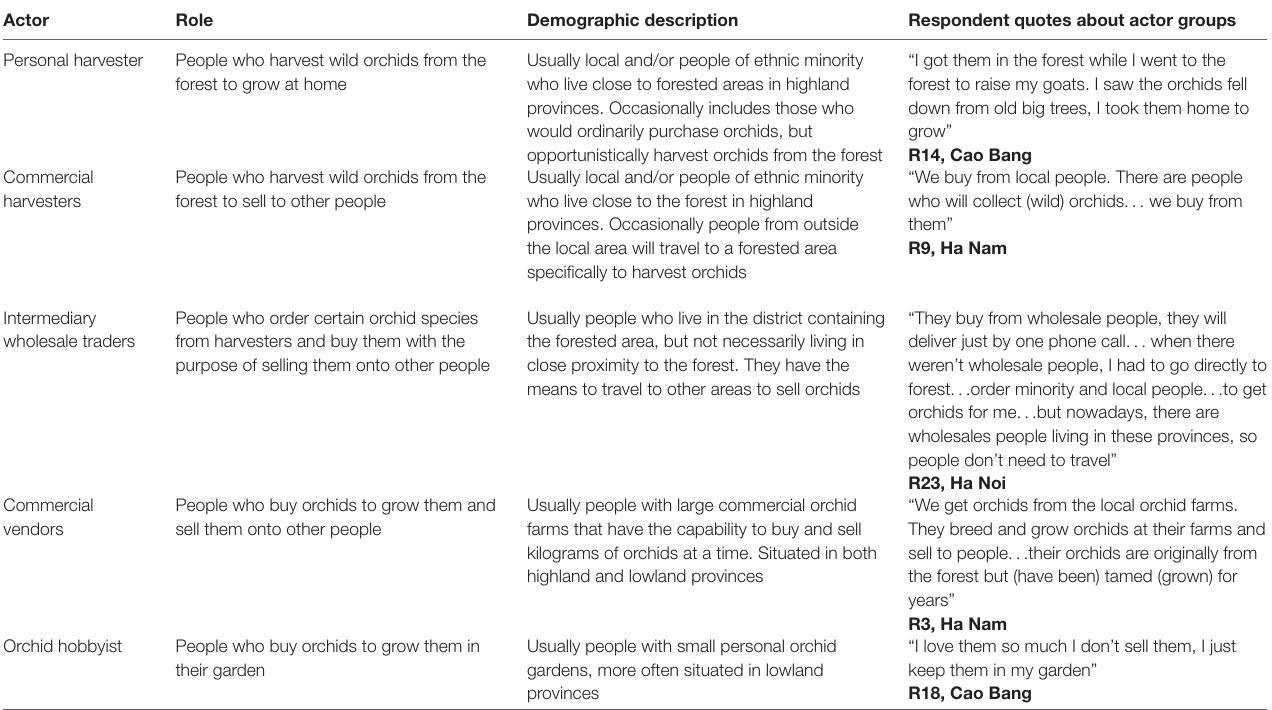
shading showing that the value is within the expected range. See SM for full results. TABLE 3 | Descriptions of the roles and demographics of different actors in the supply